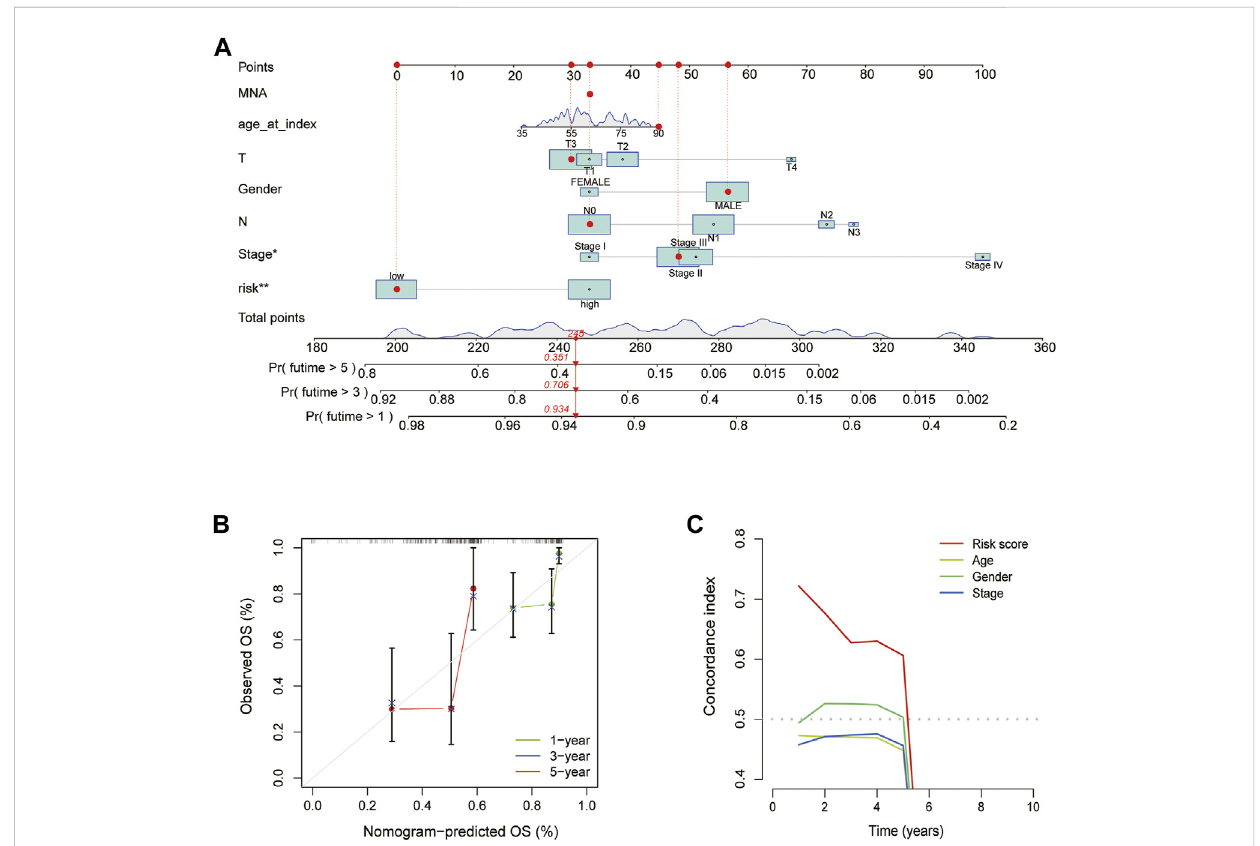
FIGURE 5 Construction and validation of the nomogram. (A) Nomogram predicts the prognosis of patients with ESCA for 1, 3 and 5 years. (B) The accuracy of Calibration curves veri fi cation results. (C) The C-index curve of the risk